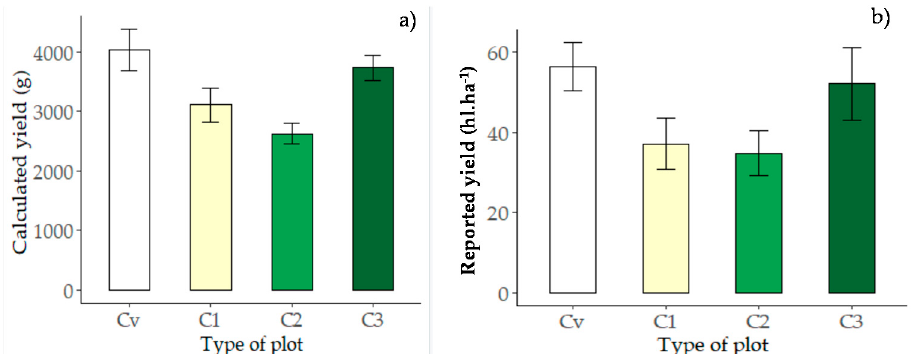
Figure 4. Yield estimation depending on the stage of vineyard plot conversion. Cv: Plots undergoing conversion, C1 to C3: Plots in the first to third years of conversion. ( a ) yield per plant calculated from monitored agronomical data and ( b ) plot yield reported by the grower. Mean ± standard deviation.